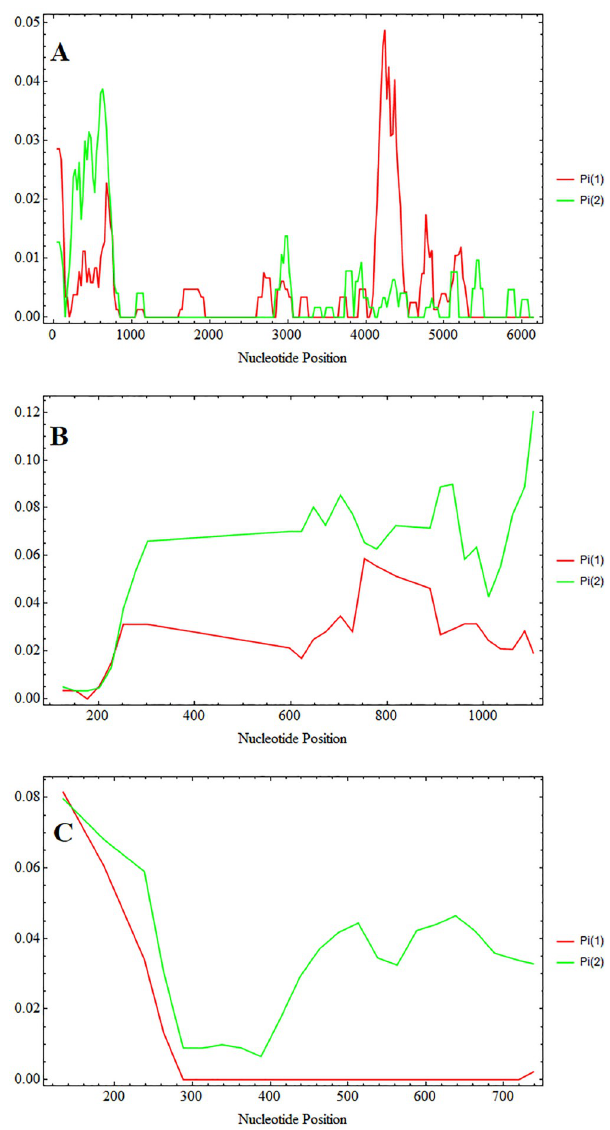
Fig 3. Sliding window plot of nucleotide diversity. Sliding plot with a window length of 100 bp and 25 bp step size using DnaSP v5 revealed nucleotide diversity between P . ovale wallikeri (Pi 1) and and P . ovale cursiti (Pi 2). The nucleotide diversity is calculated from ctrp (A), csp (B), and partial msp1 gene (C). domains is presented in Table 3. Overall, a higher number of haplotypes was observed in P . ovale curtisi as compared to P . ovale wallikeri . Whereas P . ovale wallikeri showed only one hap- lotype in conserved region I and two in conserved region II, three and six, respectively, were observed for P . ovale curtisi . A high number of haplotypes was observed in the Th2R and Th3R domains for both P . ovale curtisi and P . ovale wallikeri , but it is interesting to note that none were shared by both species. The central repeat region of pocsp was also analyzed. Several pat- terns of nine amino acid repeats were observed. A specific repeat unit was observed for P . ovale wallikeri (DPPAPVPQG), and for P . ovale curtisi NPPAPQGEG, with the latter showing a higher diversity in repeat unit numbers (Fig 2).